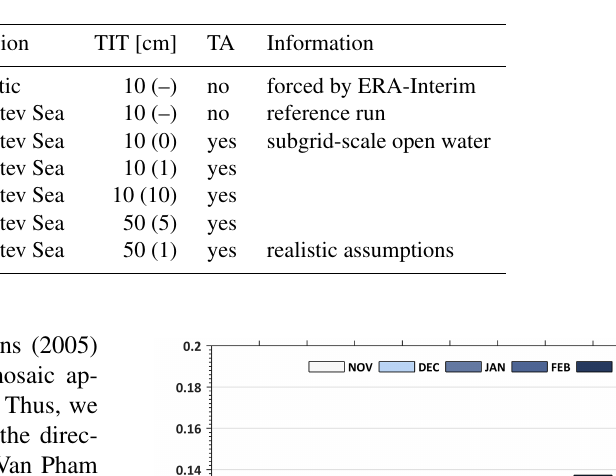
Table 1. Overview of the performed simulations with COSMO-CLM for the winter period 2007/2008. The grid-scale thin-ice thickness (TIT) within polynyas (ice concentration: 0 < SIC ≤ 70%) is shown in centimetres and the assumed subgrid-scale TIT is shown in parentheses. The latter is only required if the tile approach (TA) is used.